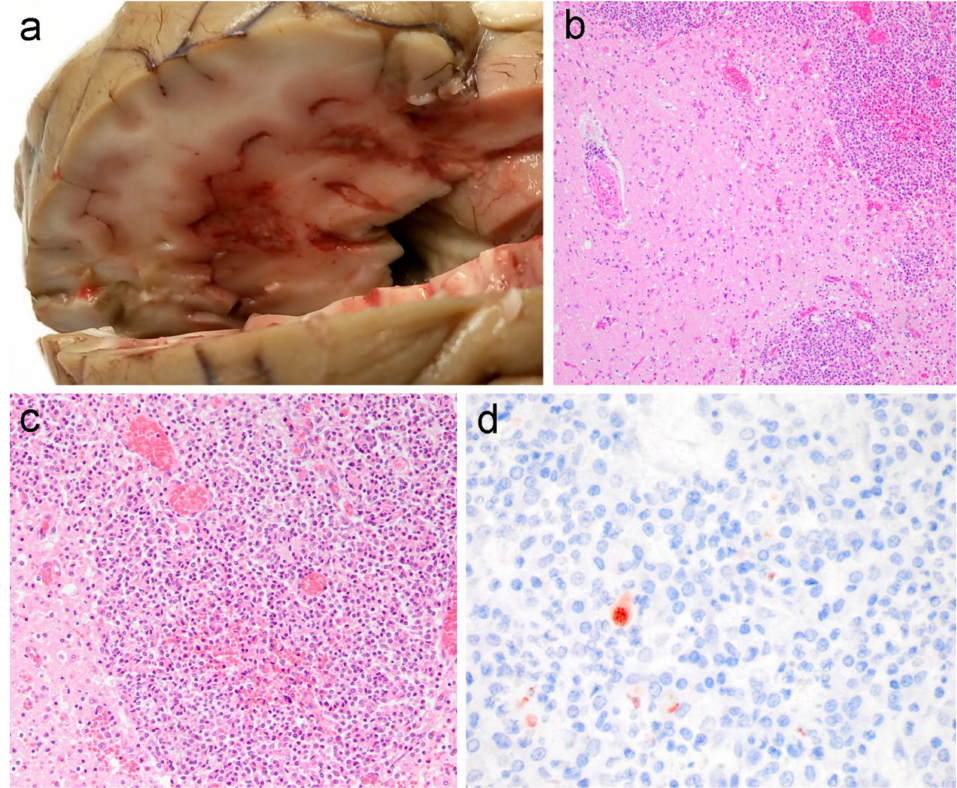
Figure 1. ( a ) Gross dissection of the cerebrum partially fixed in 10% neutral buffered formalin showing the extent and location of the lesions macroscopically. ( b , c ) Cerebrum (HE × 10 in ( b ) and HE × 20 in ( c )) extensive mixed inflammatory reaction of degenerated neutrophils, macrophages and lymphocytes. ( d ) Immunopositivity for Toxoplasma gondii ( × 60). The background of the image in panel ( a ) was